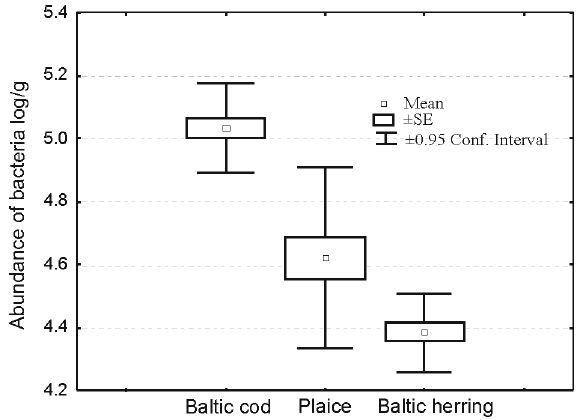
Fig. 1. Abundance of total heterotrophic bacteria in the intesti- nal tract of fish from the Baltic Sea